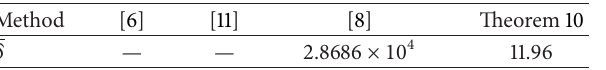
Table 4: Computed 𝛿 ’s of Example 2 for the case 𝜏 𝑚 ≤ 𝜏(𝑡) ≤ 𝜏 𝑀 , ̇𝜏(𝑡) ≤ 𝜇 with 𝜏 = 0, 𝜏 = 0.1 . 𝑚 𝑀